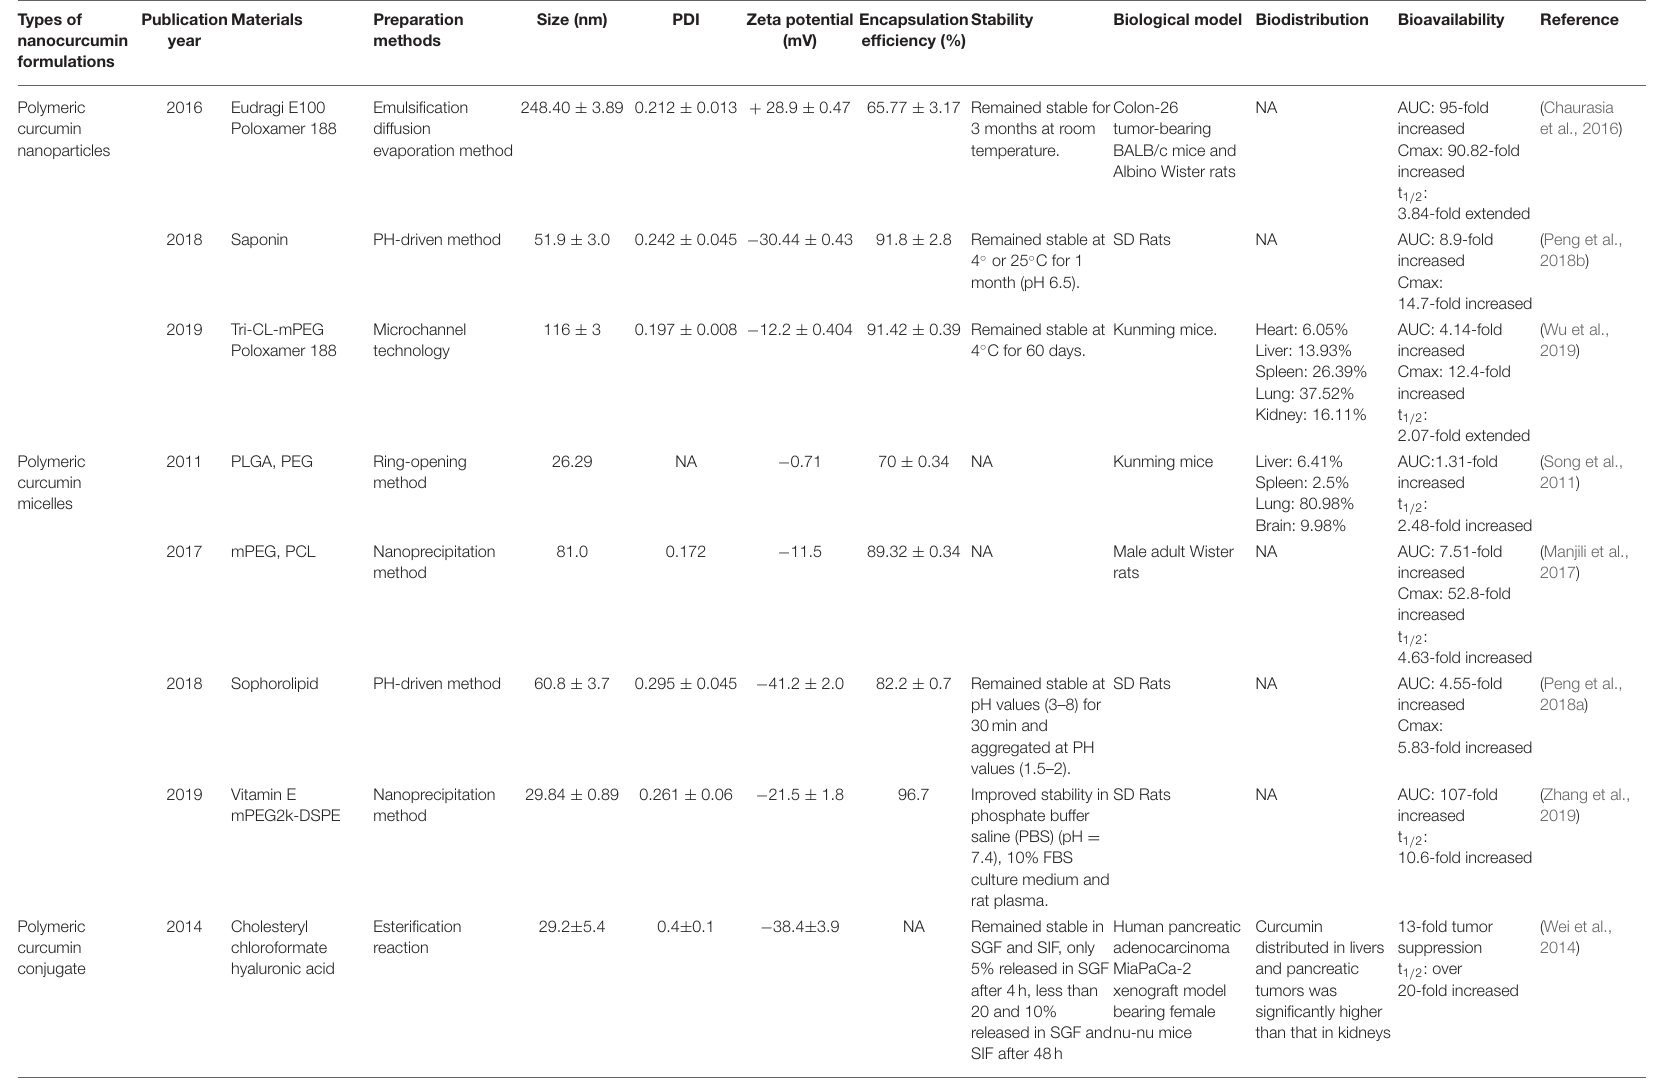
TABLE 1 | Characteristics of different nanocurcumin formulations. Types of